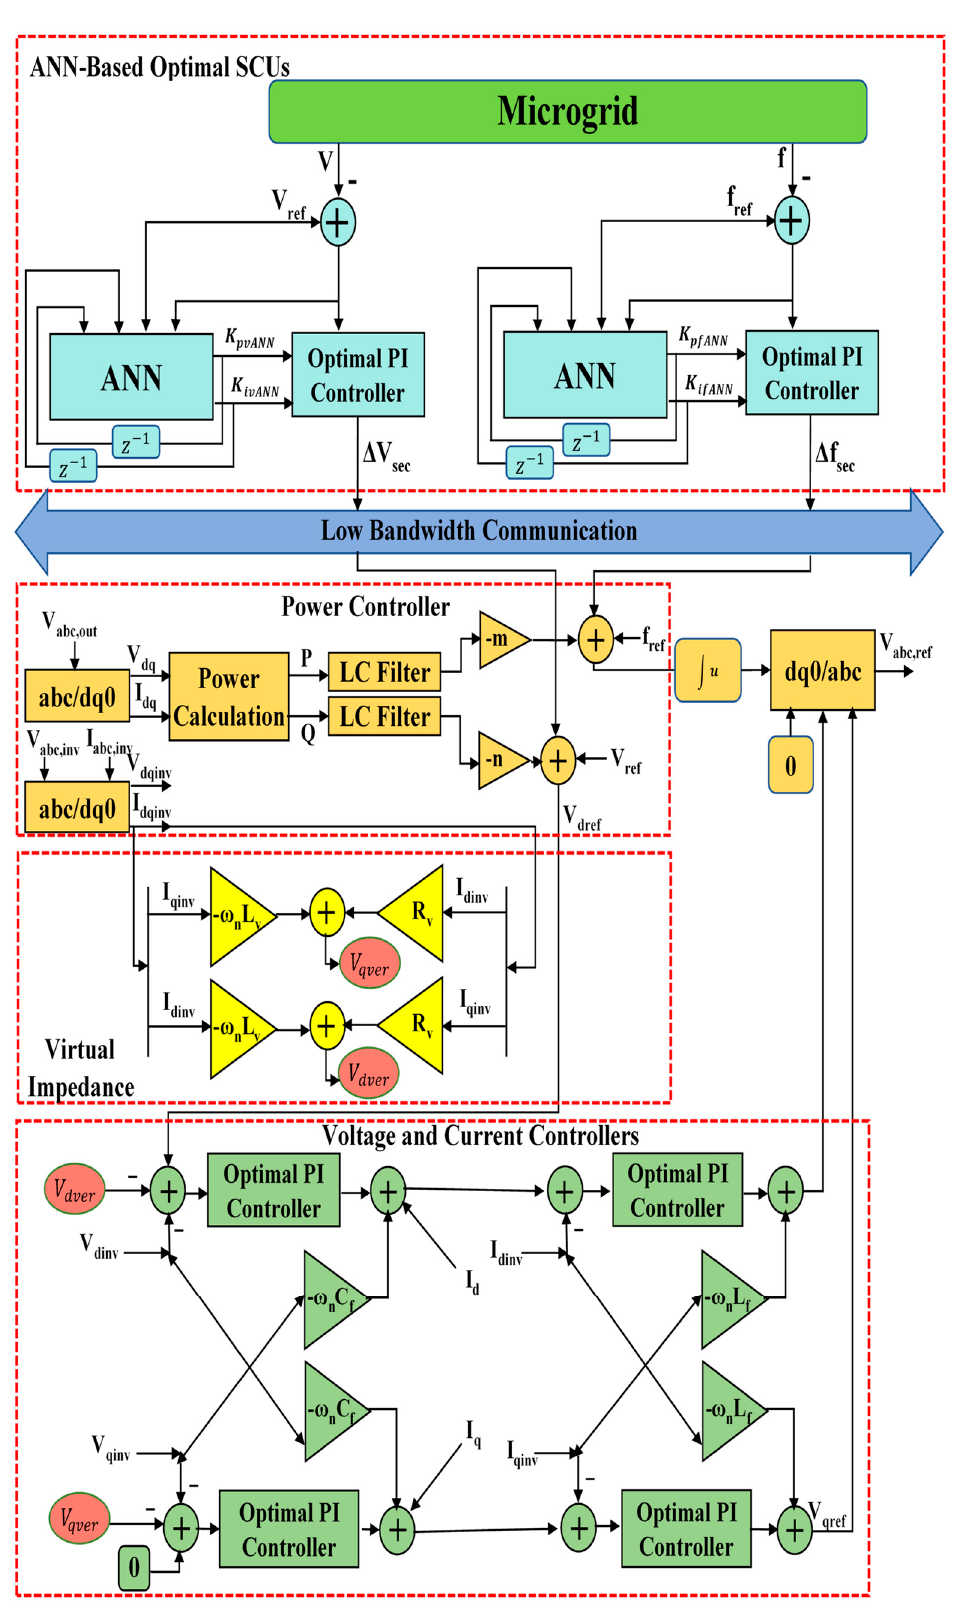
Figure 3. The control structure of each DG.